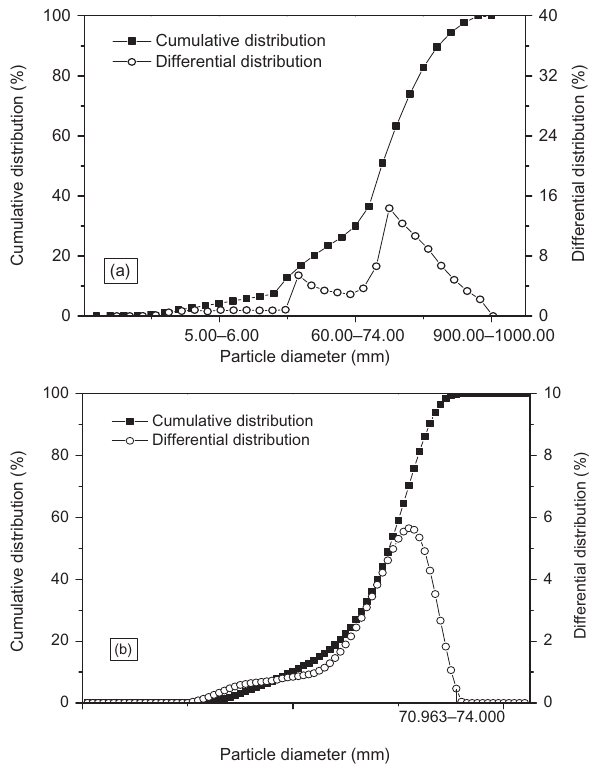
Figure 1: The particle size distribution of HCVTM before (a) and after (b) wet grinding.